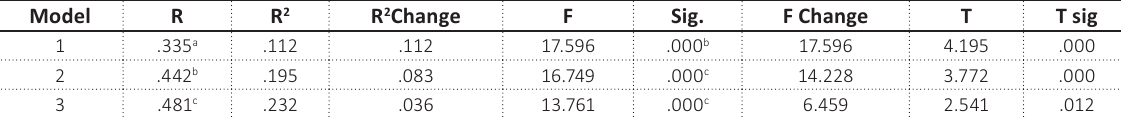
Table 6. Hierarchical regression results (H2)